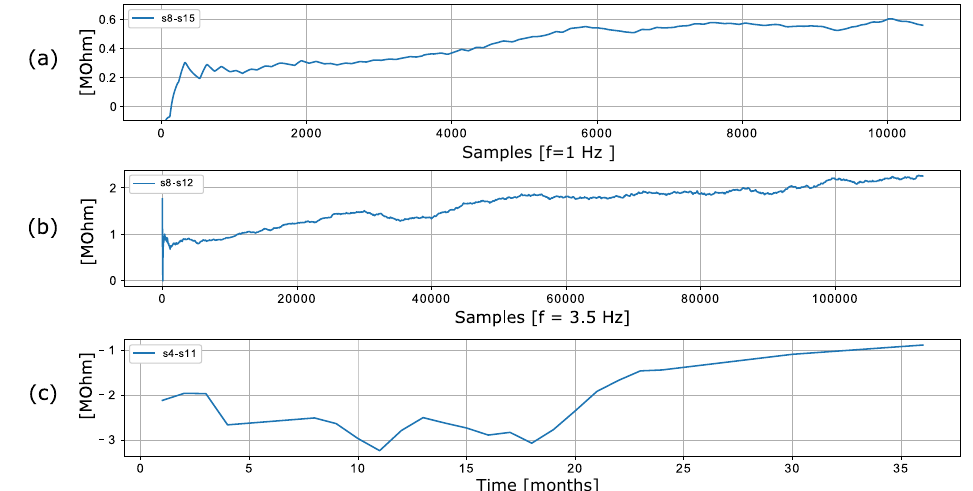
Figure 6. Discrepancy of ( a ) redundant MOX gas sensors presented in [50], ( b ) redundant gas sensors [51], and ( c ) redundant chemical sensors presented in [46].